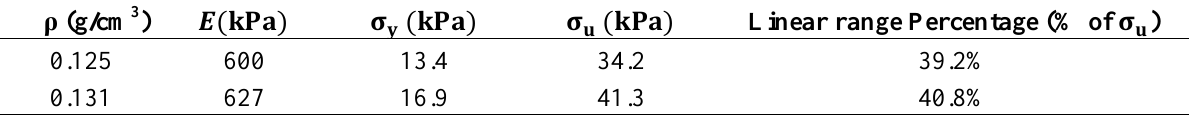
Table 1. Mechanical Properties of entangled network of carbon nanofibers. ρ (g/cm 3 ) Linear range Percentage (% of ) 0.125 600 13.4 34.2 39.2% 0.131